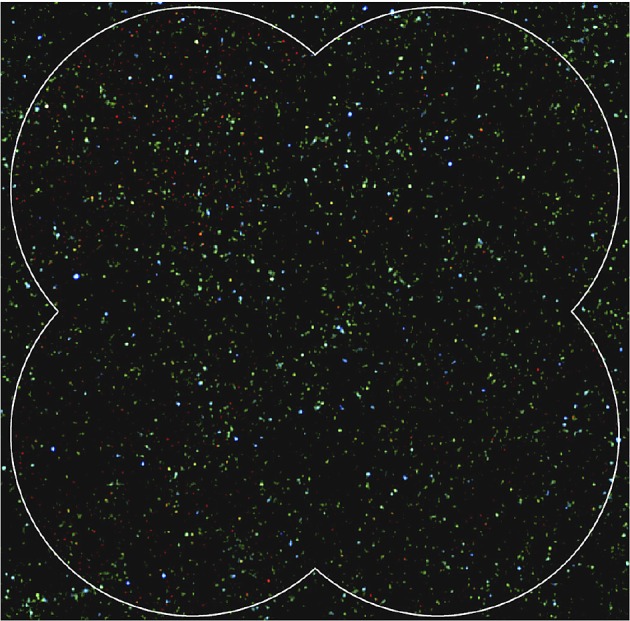
True colour image of the COSMOS field created from SCUBA-2 850 μm (red) and Herschel/SPIRE 250 μm (blue) and 350 μm (blue). The map highlights the rare dusty sources which are most probably some of the highest redshift galaxies in the sample. The white line represents the coverage of the 1.4×1.4° SC2-COSMOS map. Adapted from Matsuda [140].